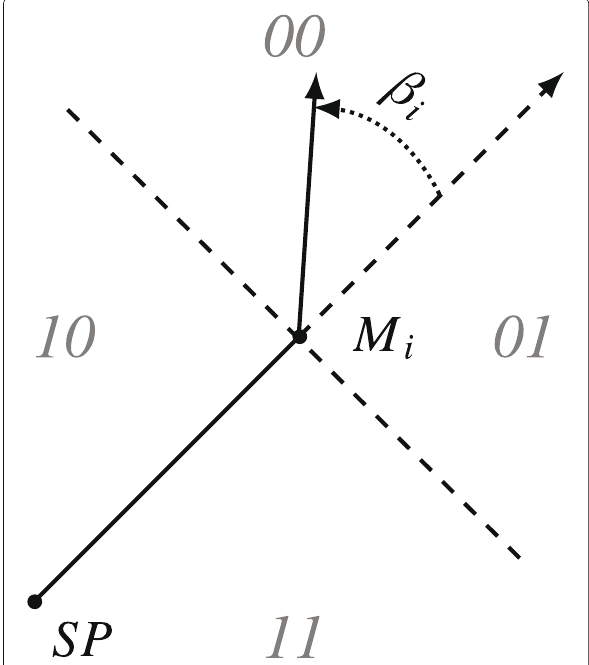
Fig. 3 Representation of the angle β i between the orientation of a minutia M i and the orientation of the edge linking M i and SP in counterclockwise